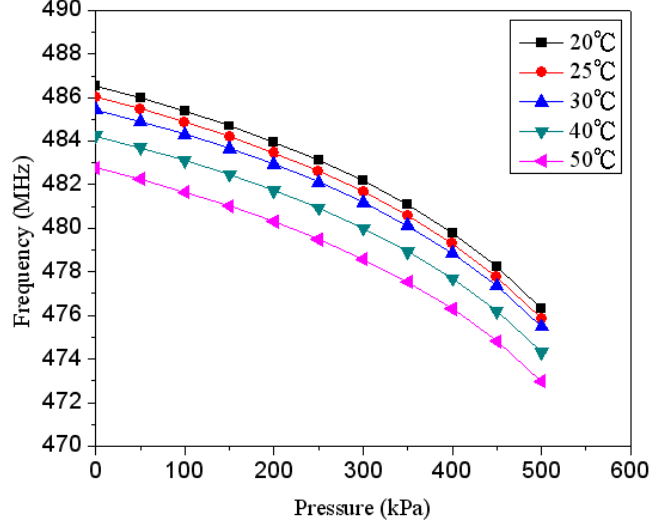
Figure 6. Output frequency of the pressure sensor at different